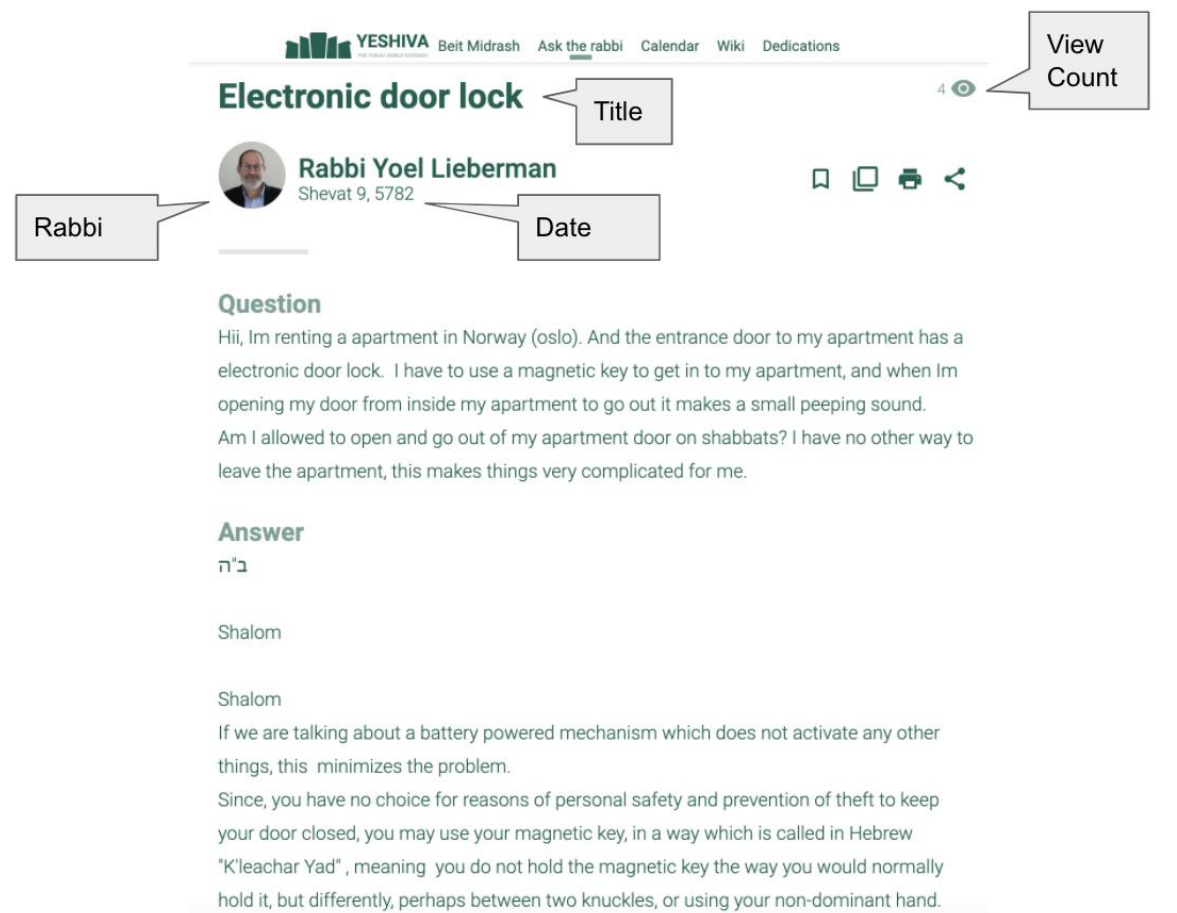
Figure 1. Example of an online responsum from the www.yeshiva.co (accessed on 6 November 2020) English website.